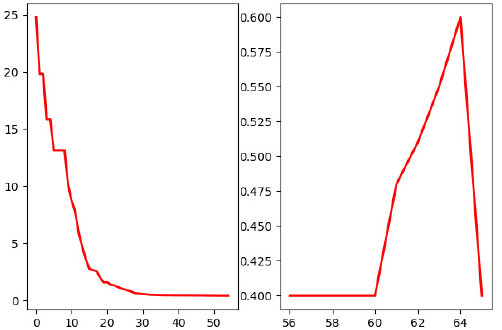
Figure 8. Validation error (x-axis: Iteration; y-axis: MSE (%)).